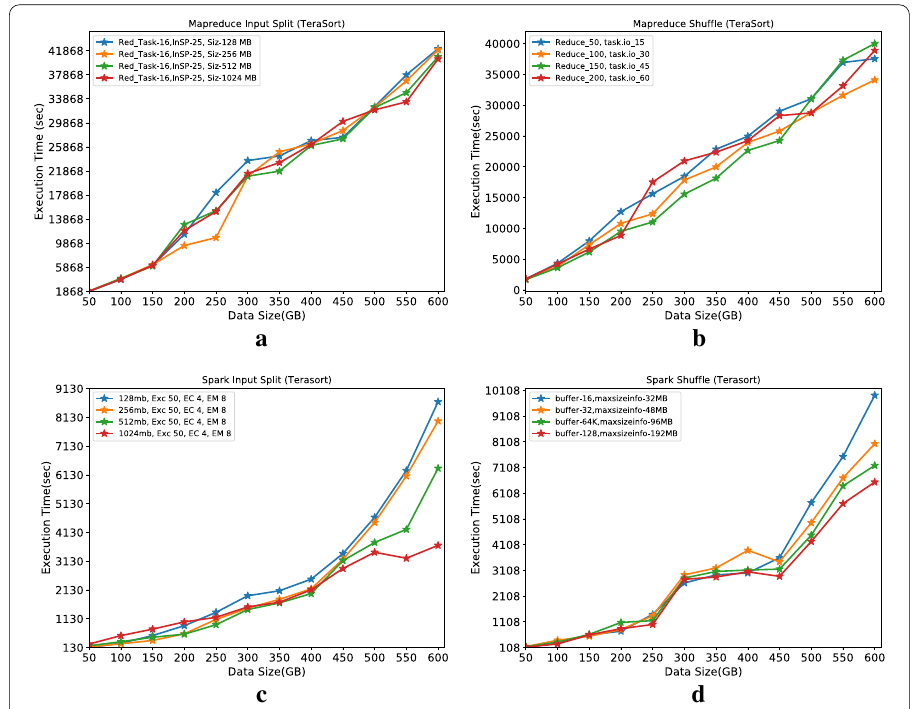
Fig. 5 The performance of the TeraSort application with a varied number of input splits and shuffle